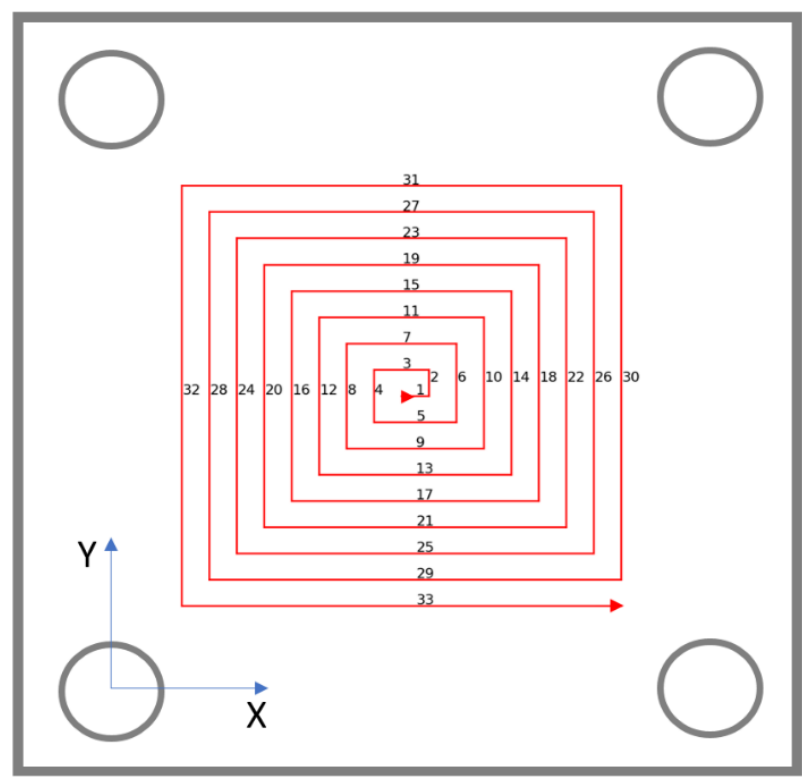
Figure 2. Followed outward helicoidal machining strategy.